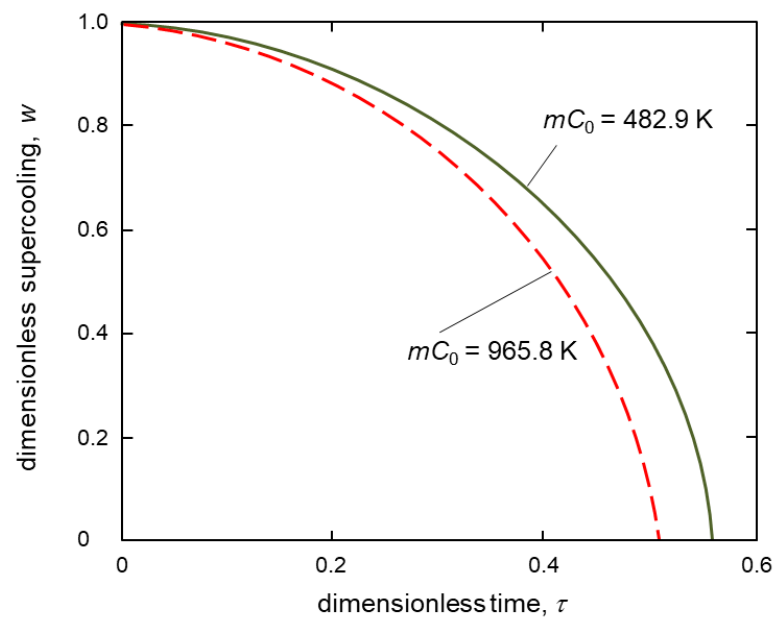
Figure 5. Dimensionless supercooling w in a binary melt as a function of dimensionless time τ at two initial concentrations C 0